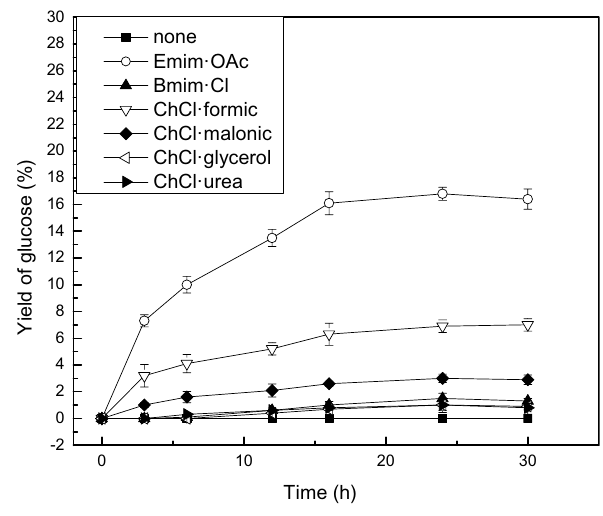
Fig. 4 Glucose yield from MCC pretreated at different temperatures with Emim·OAc (closed symbols) and with ChCl·formic acid (open symbols). Reaction conditions: 0.05 g MCC, 0.1 g solid acid catalyst and 4 mL deionized water, 363